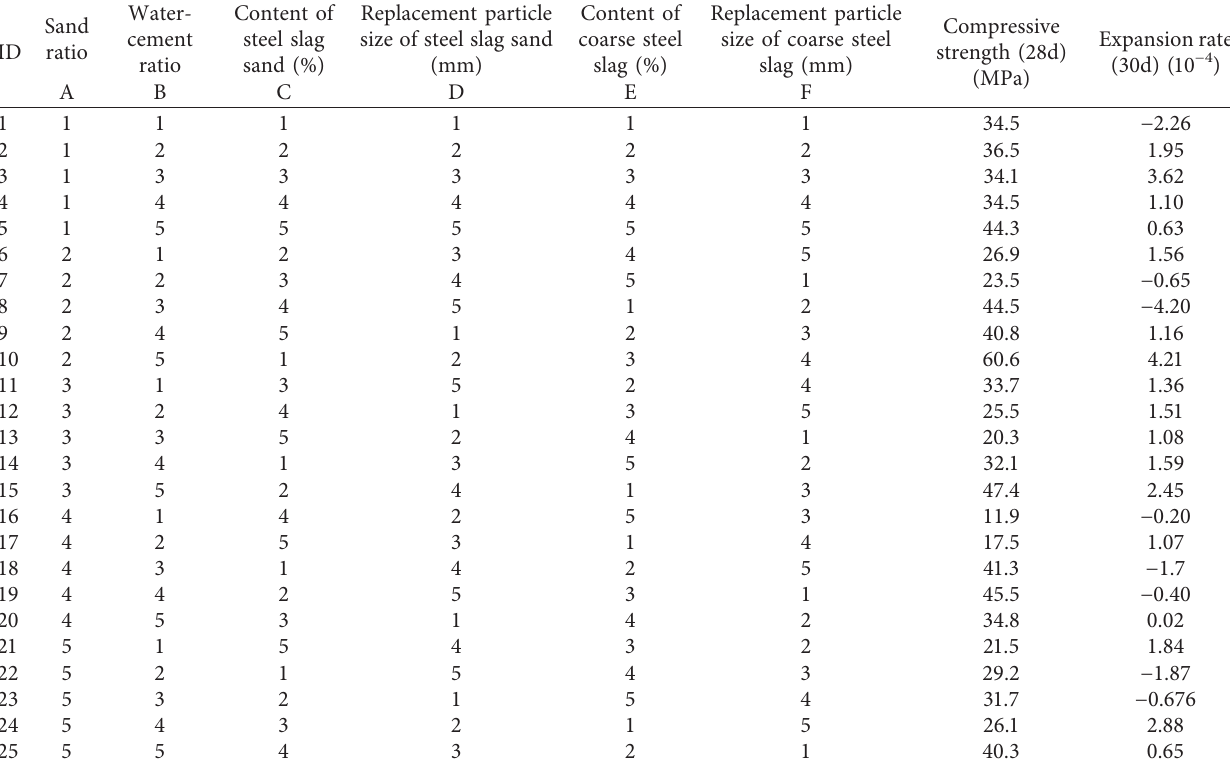
Table 3: The bit-level table of the orthogonal test and test